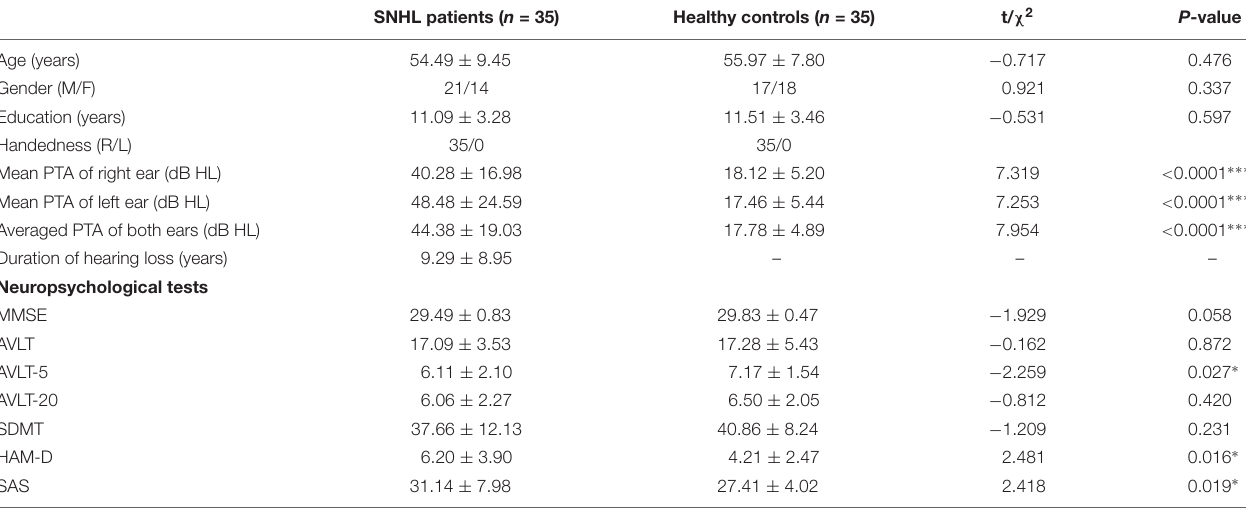
TABLE 1 | Demographic, clinical, and neuropsychological characteristics of the patients with SNHL and healthy controls. SNHL patients ( n = 35) Healthy controls ( n = 35) t/ χ 2